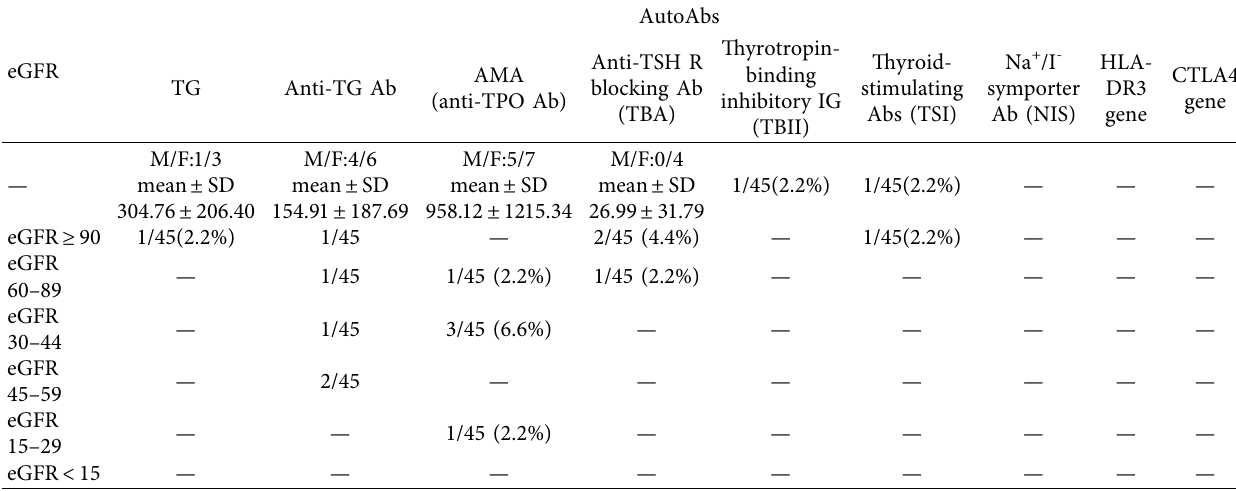
Table 3: Distribution and mean values of thyroid autoantibodies in thyroid-kidney dysfunction.